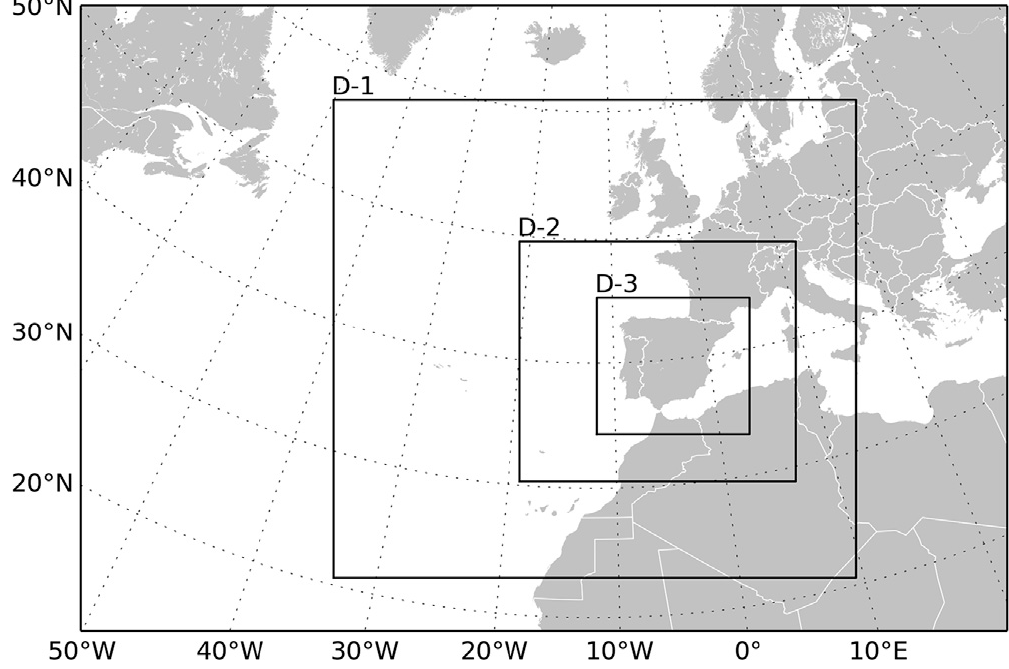
Figure 1. Domain configuration used with the Weather Research and Forecasting (WRF) model.